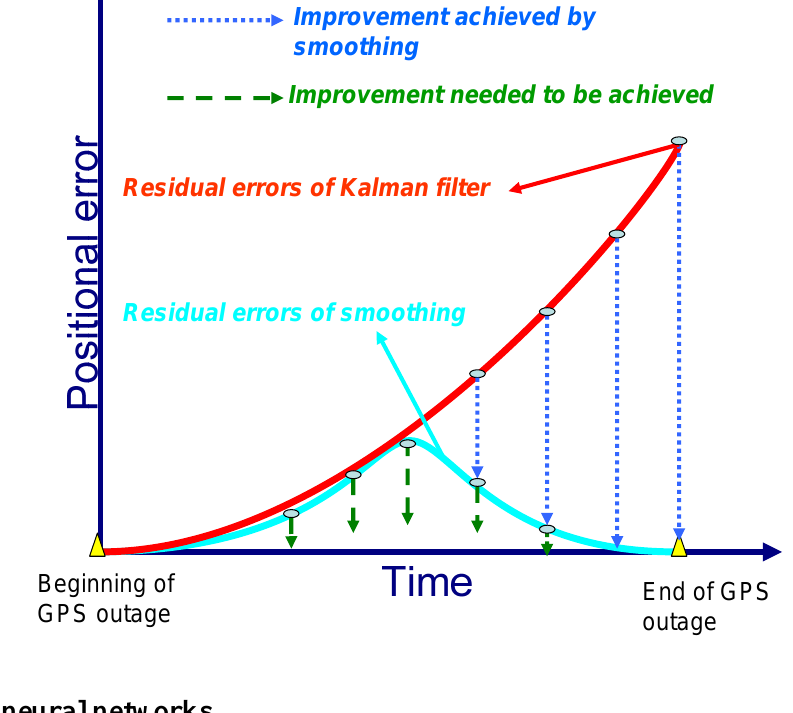
Figure 4. The impact of smoother on the positioning error during GPS